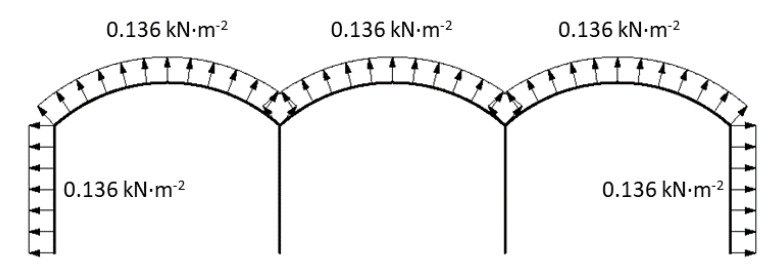
Figure 9. 0°-wind load values according to EN 13031-1 [53]. Figure 9. 0 ◦ -wind load values according to EN 13031-1 [53].